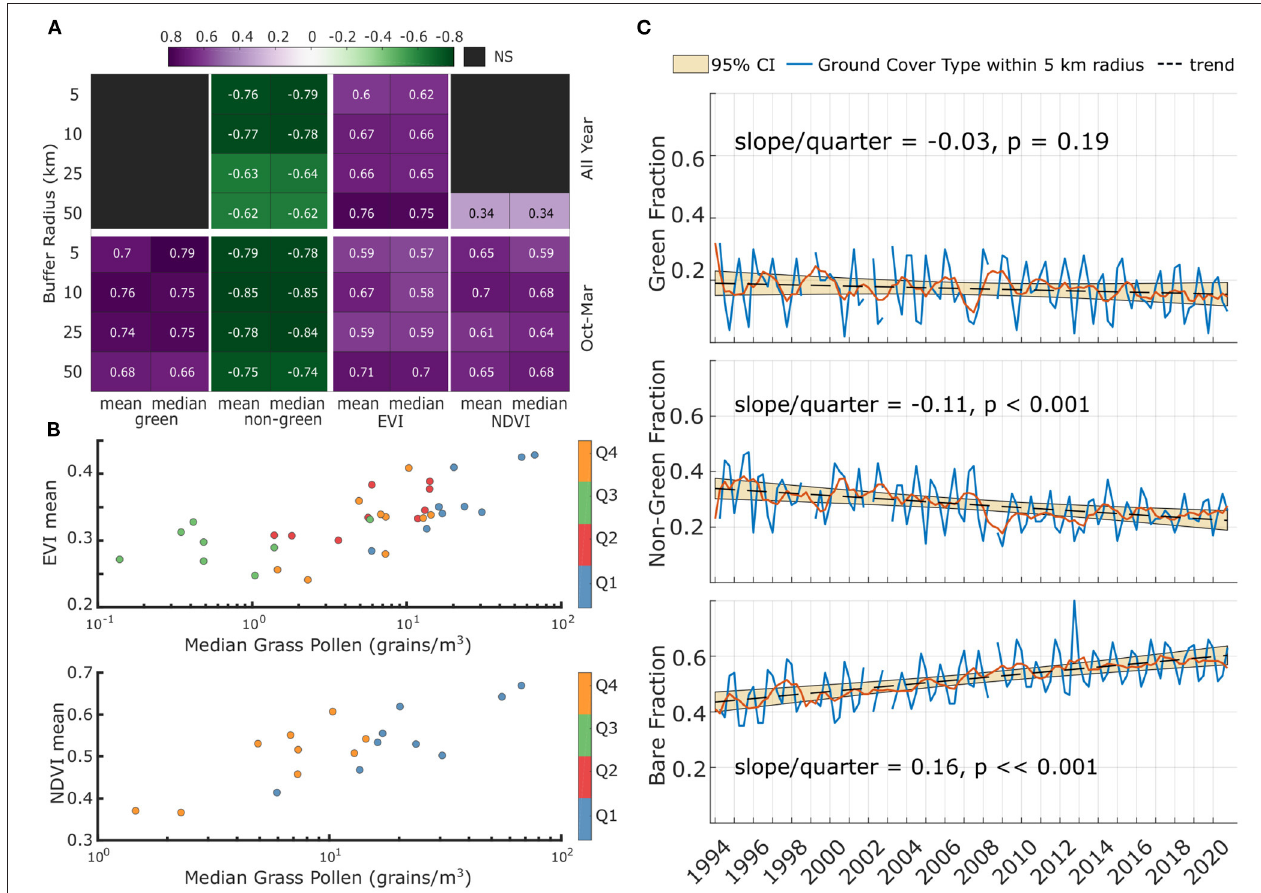
FIGURE 4 | Satellite-derived vegetation measures and correlations with grass pollen within 5km of the pollen sampler (A) Spearman correlations of median quarterly pollen with groundcover fractions (left) and VI (right); (B) Scatter plots of mean quarterly VI and median pollen for the 50km radial buffer; (C) Regressions of groundcover fractions over 27